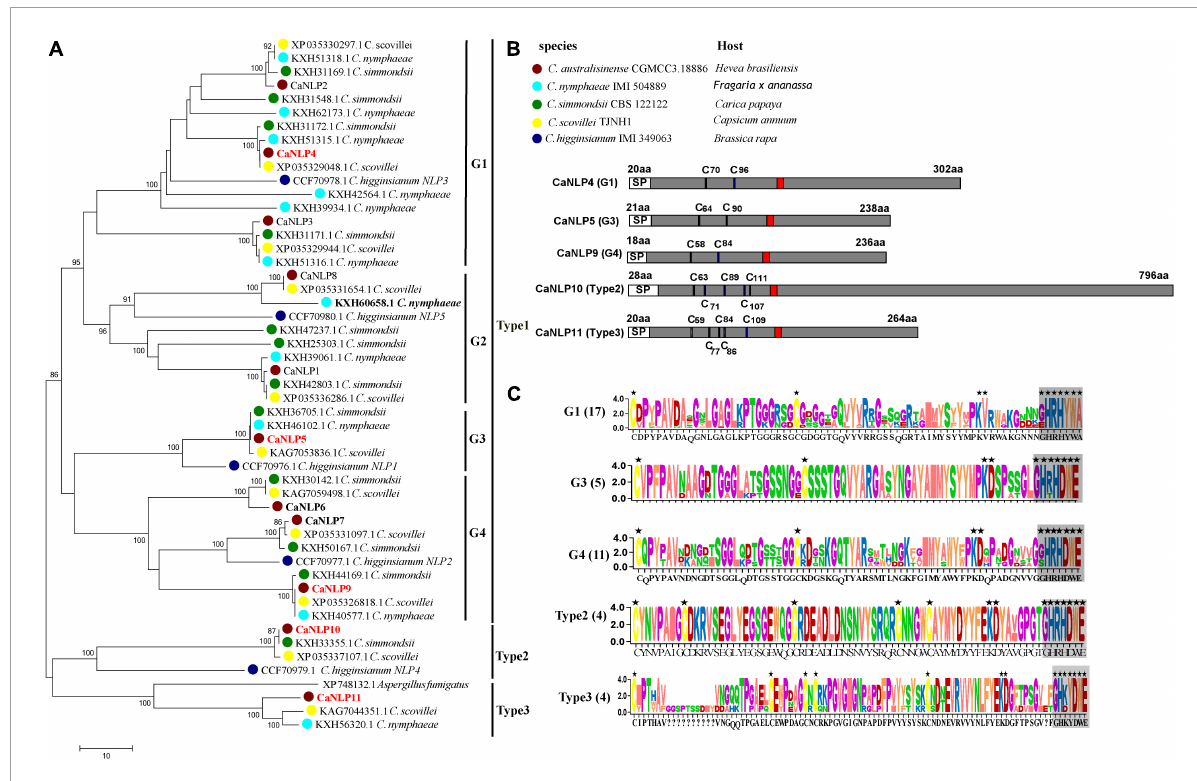
FIGURE1 Phylogenetic relationships and sequence characteristics of all predicted Nep1-like proteins (NLPs). (A) Phylogenetic relationships of NLPs between Colletotrichum australisinense and other species in the Colletotrichum acutatum species complex inferred using maximum likelihood with 1,000 bootstrap replicates. Bold black NLPs lack the heptapeptide motif. Red NLPs were analyzed in necrosis-inducing activity and expression experiments. (B) Schematic representation of different groups and types NLP. “C” indicates the conserved cysteine residues. Red region indicates the conserved heptapeptide motif “GHRHDWE.” (C) Consensus sequence logos of different NLP groups and types. Black stars indicate the key residues responsible for necrosis activity, and box-shadows indicate the heptapeptide